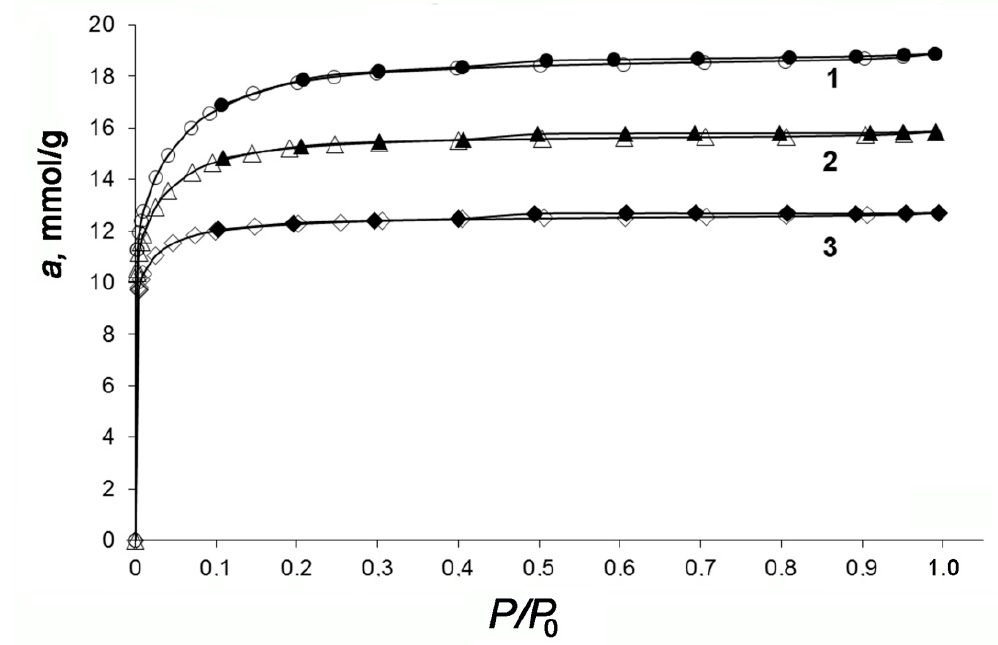
Figure 3. Nitrogen adsorption (dark symbols) / desorption (light symbols) isotherms at 77 K on AC-90S (1), AC-90L (2), and AC-60L (3). Symbols show the experimental data; solid lines are the results of approximation.